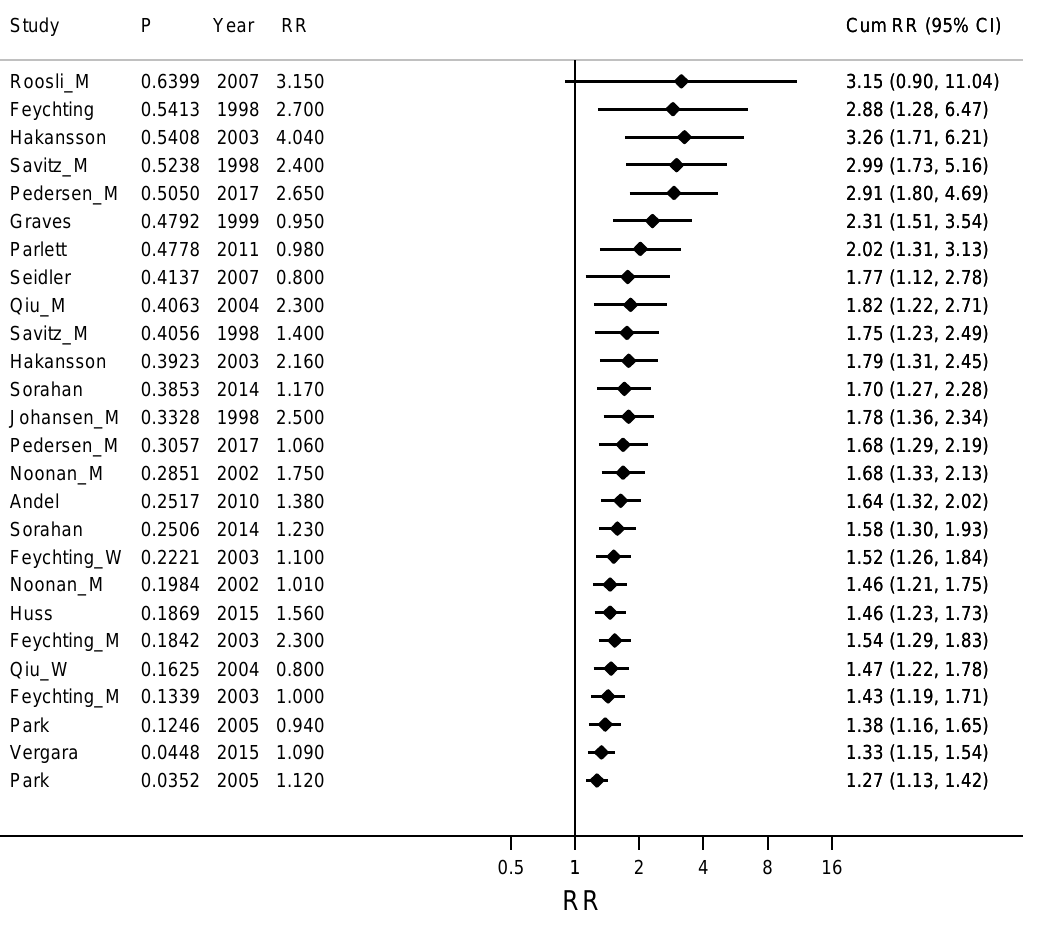
Figure 4. Cumulative meta-analyses for studies ordered by precision of the confidence interval for RR, from low precision with wide confidence intervals for RR to studies with high precision and narrow confidence intervals. The association between ALS (amyotrophic lateral sclerosis) and Alzheimer’s disease together and occupational exposure to electromagnetic fields (EMFs) is described. The pooled estimate (Cum RR) is updated for every new study. Column P gives a measure of the precision for the confidence interval for RR, where large P stands for a wide confidence interval and small P stands for a narrow and more precise confidence interval. RR is the Relative Risk for the study included in the Cum RR.